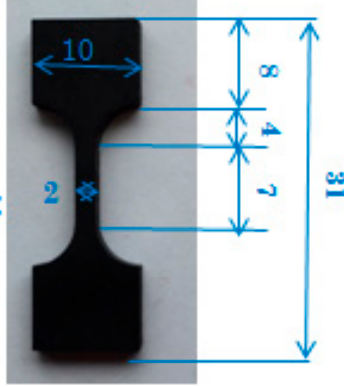
Figure 1. Dumbbell-shaped specimens developed in our laboratory.